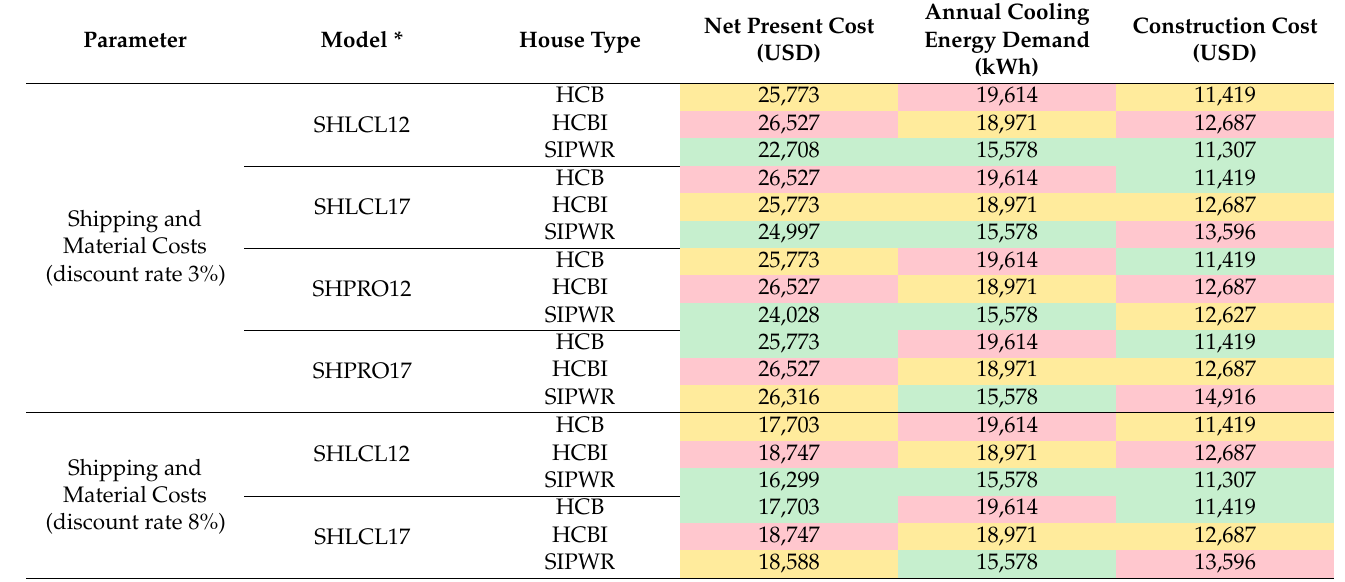
Table 11. Tabular representation of various parameters results obtained for the Hollow Core Block (HCB), Hollow Core Block-Insulated (HCBI) and the Structural Insulated Panel Wall (SIPWR) types (with colour coding—red represents the highest cost/energy use, green represents the lease cost/energy use and yellow represents the intermediate